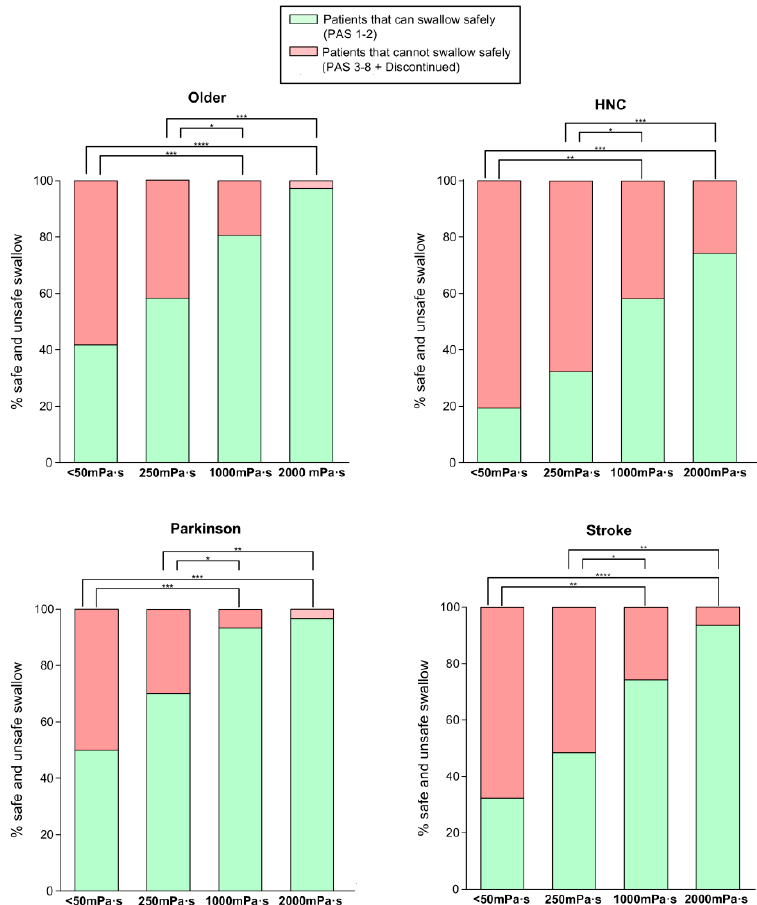
Figure 4. Percentage of patients who could swallow safely vs. those who could not swallow safely at each viscosity level. * p -value < 0.05, ** < 0.01, *** < 0.001, **** < 0.001. HNC: head and neck cancer.